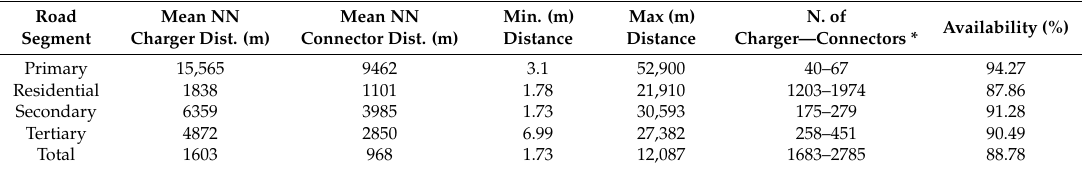
Table 1. Average nearest neighbor (NN) distances to connector and to column.